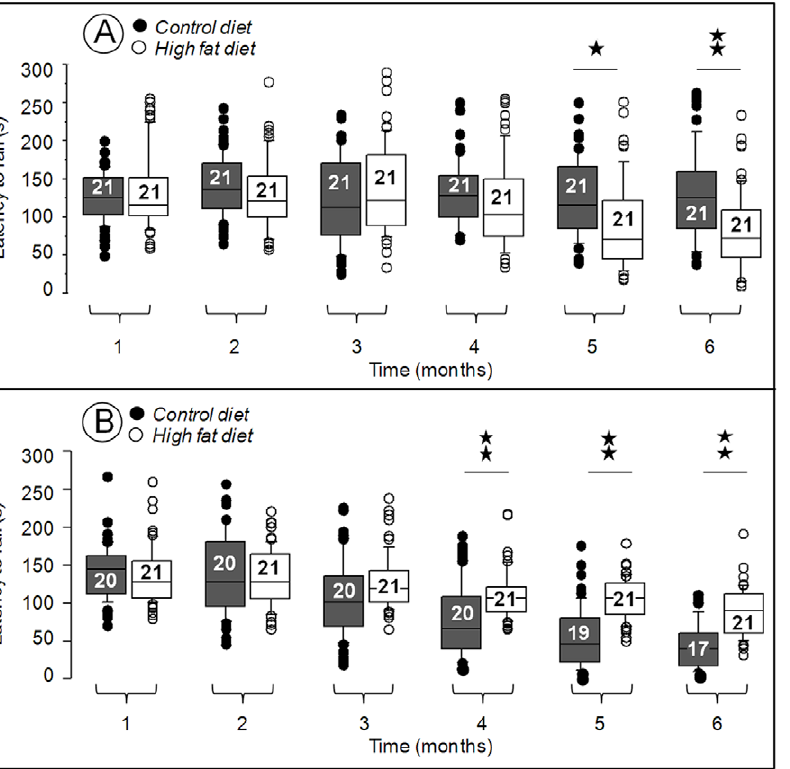
Figure 4. Box-and-whisker plot of rotarod scores as a function of diet (HFD versus CD) according to age in Harlequin (Hq) and wild type (WT) animals. The results of three tests per animals performed monthly from one to six months of age are shown with the number (n) of animals indicated in each box. The vertical bars represent the range of values from the 10 th to the 90 th percentile; the boxes represent the values from the 25 th to the 75 th percentile; the horizontal lines represent the median value for each group of animals. Isolated circles represent all observations (in triplicates) below the 10 th percentile or above the 90 th percentile. *: p , 0.05; **: p , 0.01 (Student’s two-tailed t test). HFD-fed WT mice exhibit significantly worse performances than the WT mice fed the CD, from 5 months of age due to their obese phenotype (A). From 4 months of age, HFD- fed Hq mice do significantly better than the Hq fed the CD with a significantly lower progression of the rotarod scores loss (B).